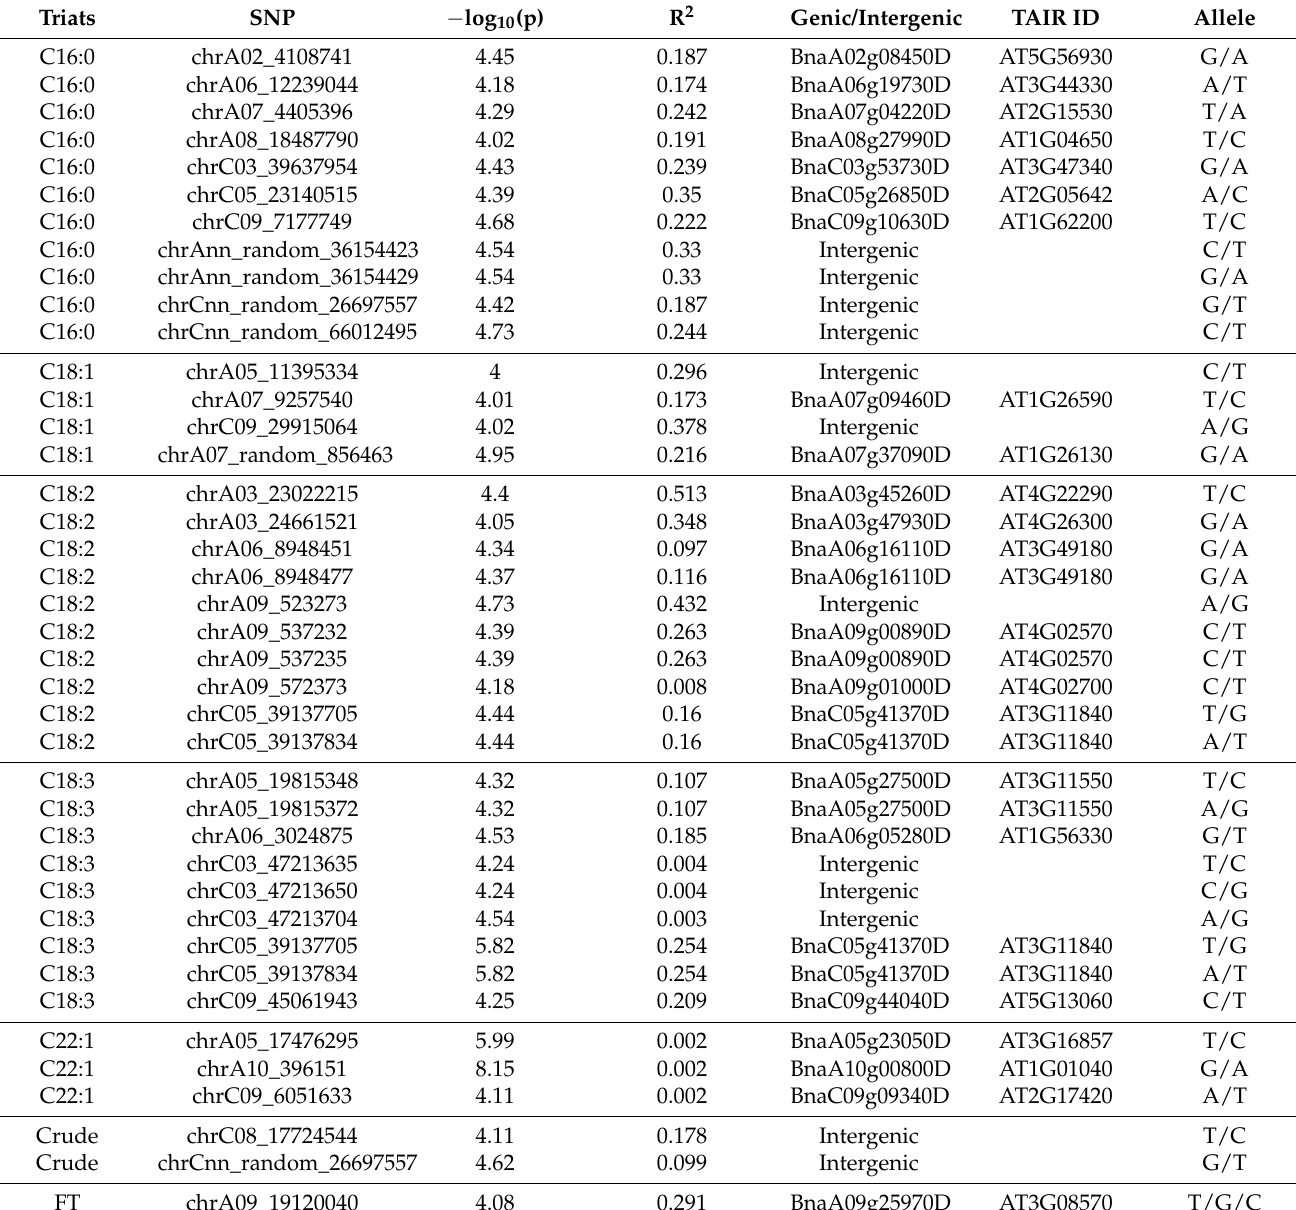
Table 4. List of 40 significant associated SNPs with fatty acid and flowering types by association